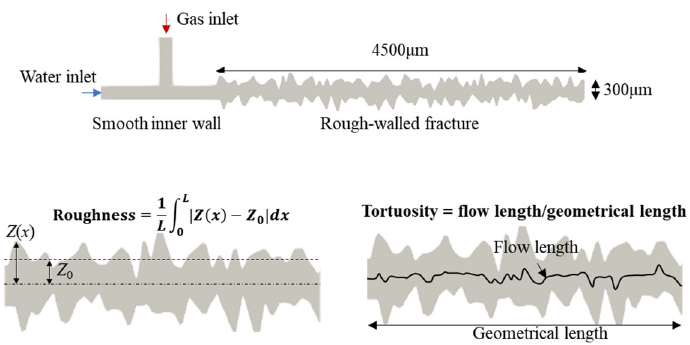
Figure 3. The basic geometry of a rough-walled single-fracture model.